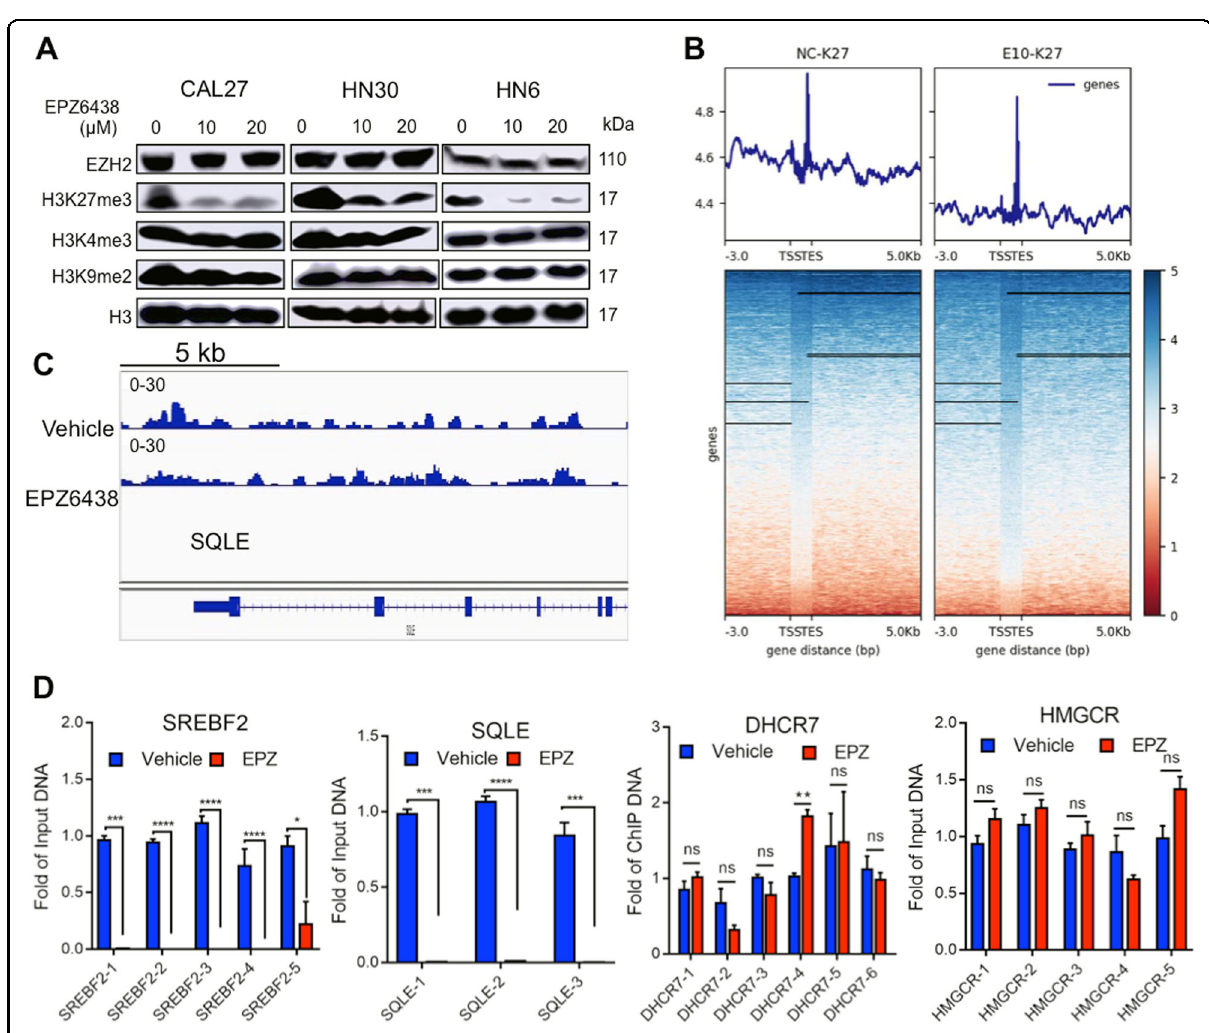
Fig. 2 EZH2 regulates cholesterol synthesis through H3K27me3. A Immunoblotting analysis to examine the methylation modi fi cation of different histone residues by the EZH2 inhibitor EPZ6438. B Heatmaps of H3K27me3 ChIP-Seq signals at the TSS in vehicle- and EPZ6438-treated CAL27 cells. C Genome browser view of normalized ChIP-seq signals of H3K27me3 at the SQLE locus in vehicle and EPZ6438-treated CAL27 cells. D ChIP-PCR analysis to examine the level of H3K27me3 modi fi cation in the promoter regions of different target genes after CAL27 cells were treated with vehicle or EPZ6438. N = 3 replicates, t -test analysis was used to assess the statistical signi fi cance, * p < 0.05, ** p < 0.01, *** p < 0.001, **** p <